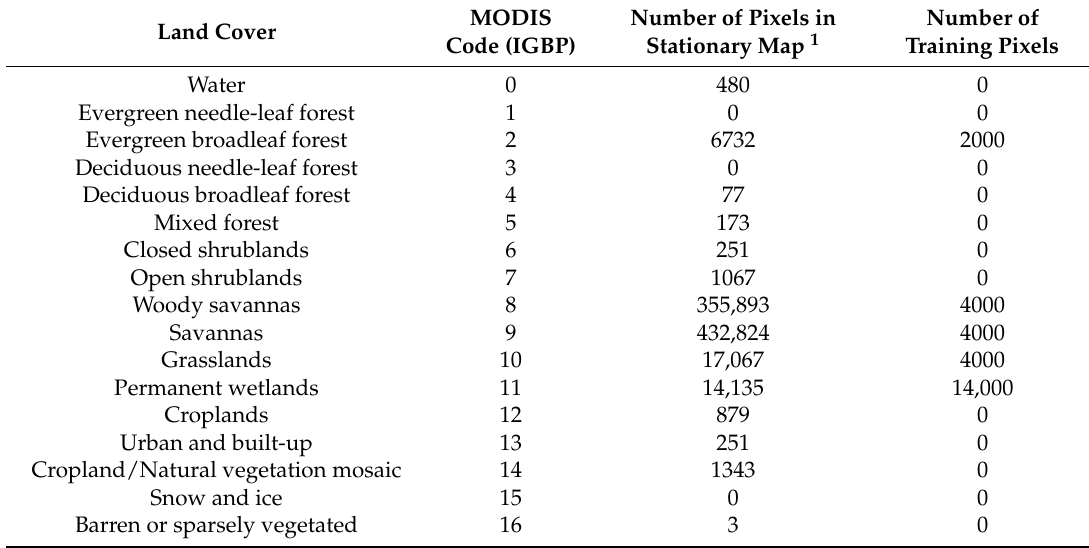
Table 2. Summary of training pixels (28,000 total) for each MODIS land cover type. MODIS Number of Pixels in Number of Land Cover Code (IGBP) Stationary Map 1 Training Pixels Water 0 480 0 Evergreen needle-leaf forest 1 0 0 2 6732 2000 3 0